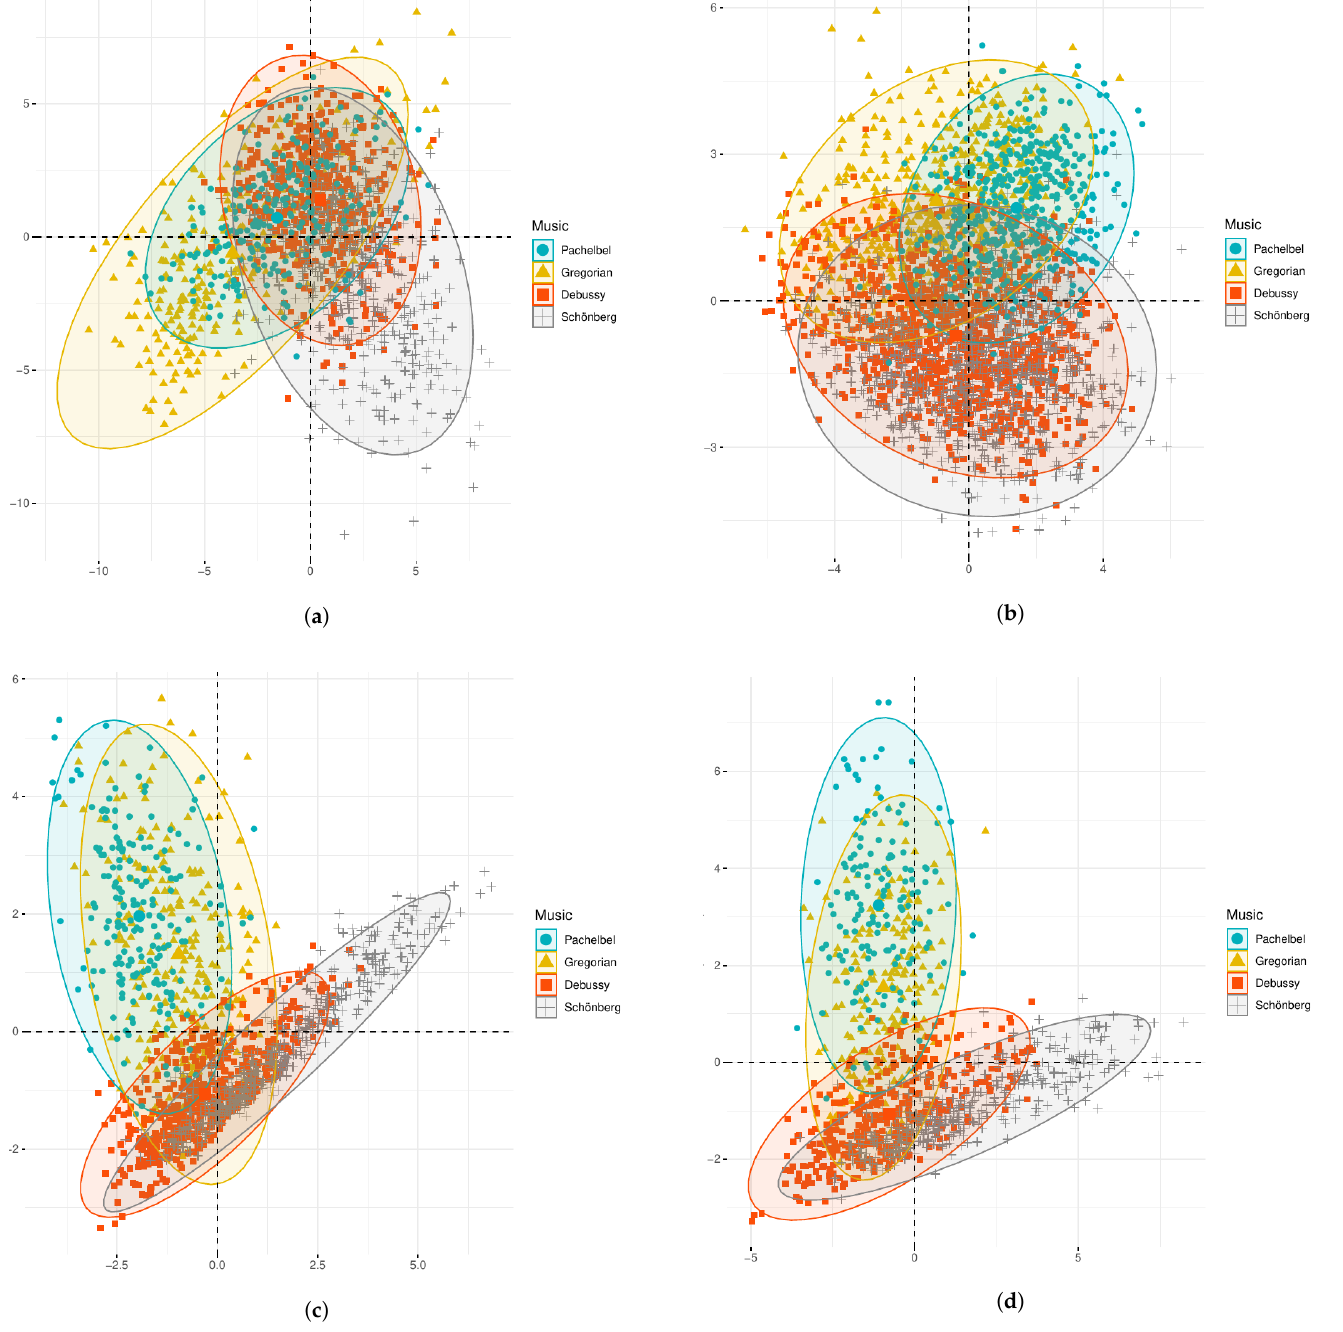
Figure 2. Principal Component (PC) representation for the LLDs in ComParE , eGeMAPS , EmoMusic , and NoAnx . Constellations for each sample: Pachelbel’s canon, Gregorian chant, Debussy’s sample, and Schönberg’s sample, are shown. ( a ) First and second PCs for ComParE . ( b ) First and second PCs for eGeMAPS . ( c ) First and second PCs for EmoMusic . ( d ) First and second PCs for NoAnx